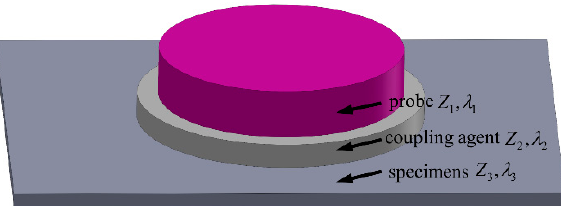
Figure 1. Principle of acoustic impedance matching.